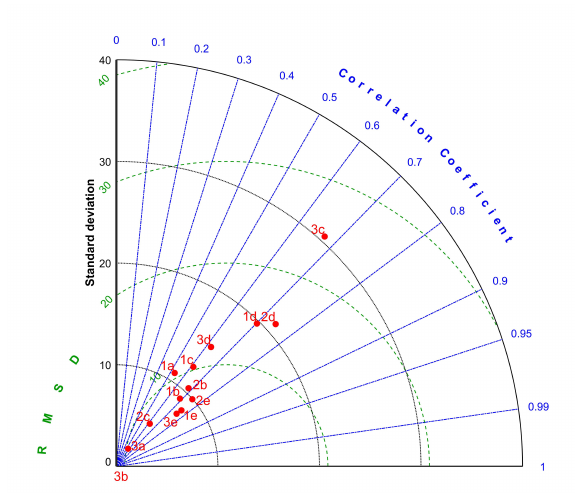
Figure 3. RPC 2.6, 4.5 and 8.4 scenario 15 models of Hetao area annual precipitation estimate Taylor